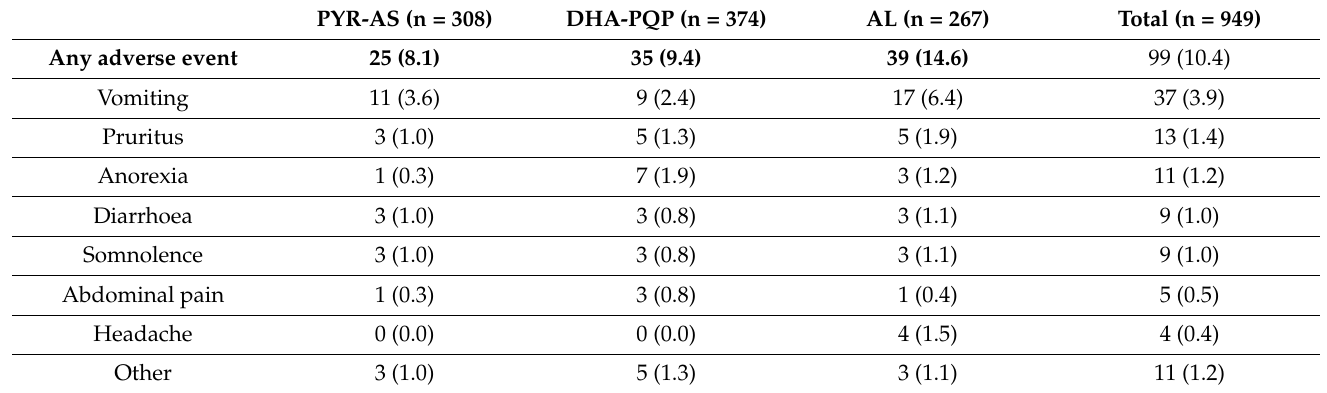
Table 5. Occurrence of adverse events after treatment with study